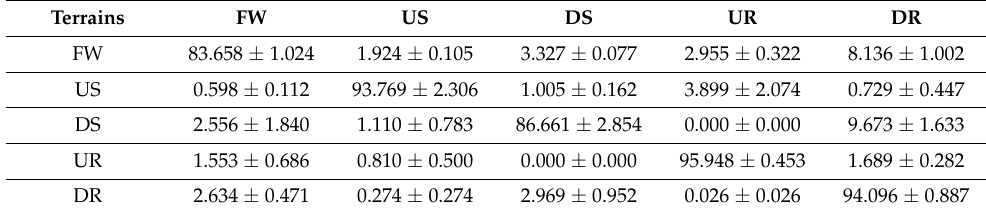
Table 3. Confusion matrix (MEAN ± SEM) for experimental results of SVM (%).